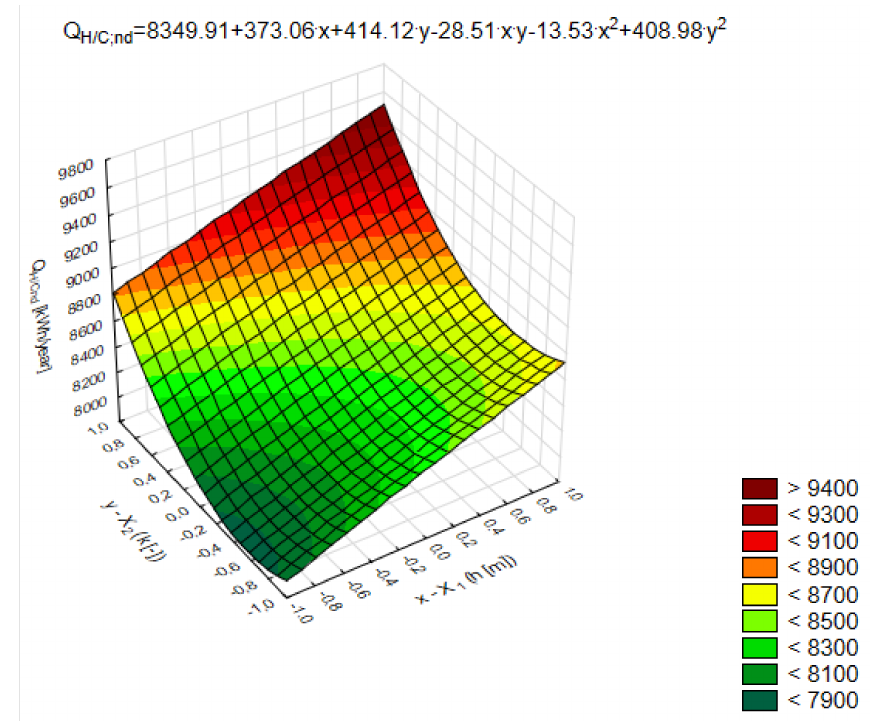
Figure 9. Dependence of Q H/Cnd on factors from the first group of parameters, i.e., architectural and spatial: X 1 —the height of rooms in the building h and X 2 —the window area changes coefficient k .